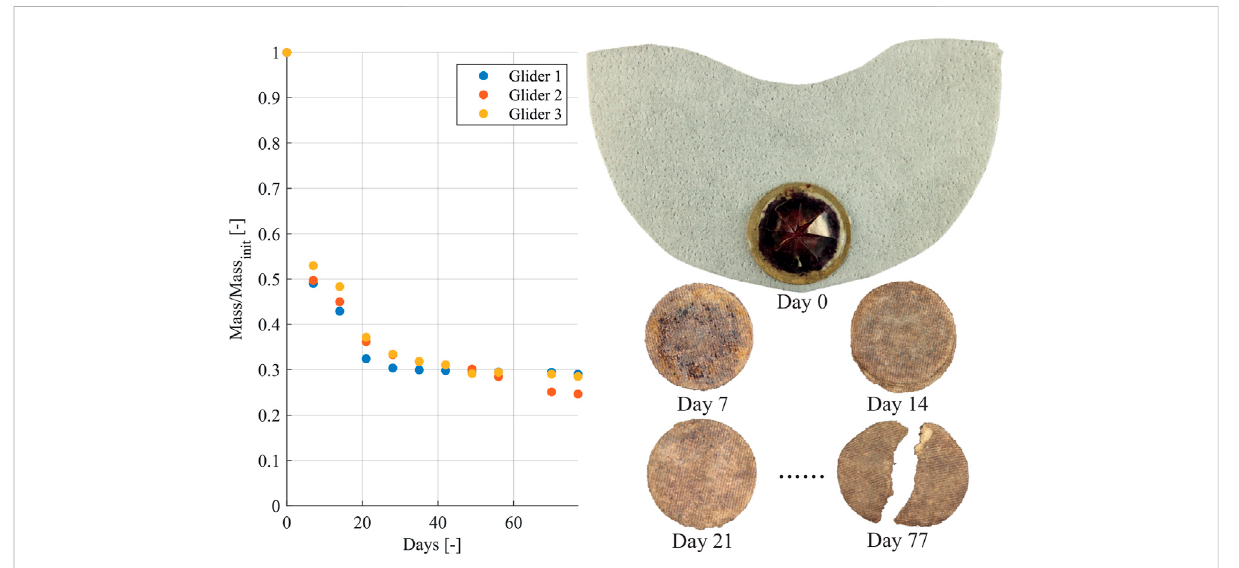
FIGURE 11 Theweightlossofthegliderduring77 daysisshown.Fortheweek0,1,2,3and11animageofthe fi rstgliderisgiven.Notethattheglider ’ swing completely degrades after 7 days of